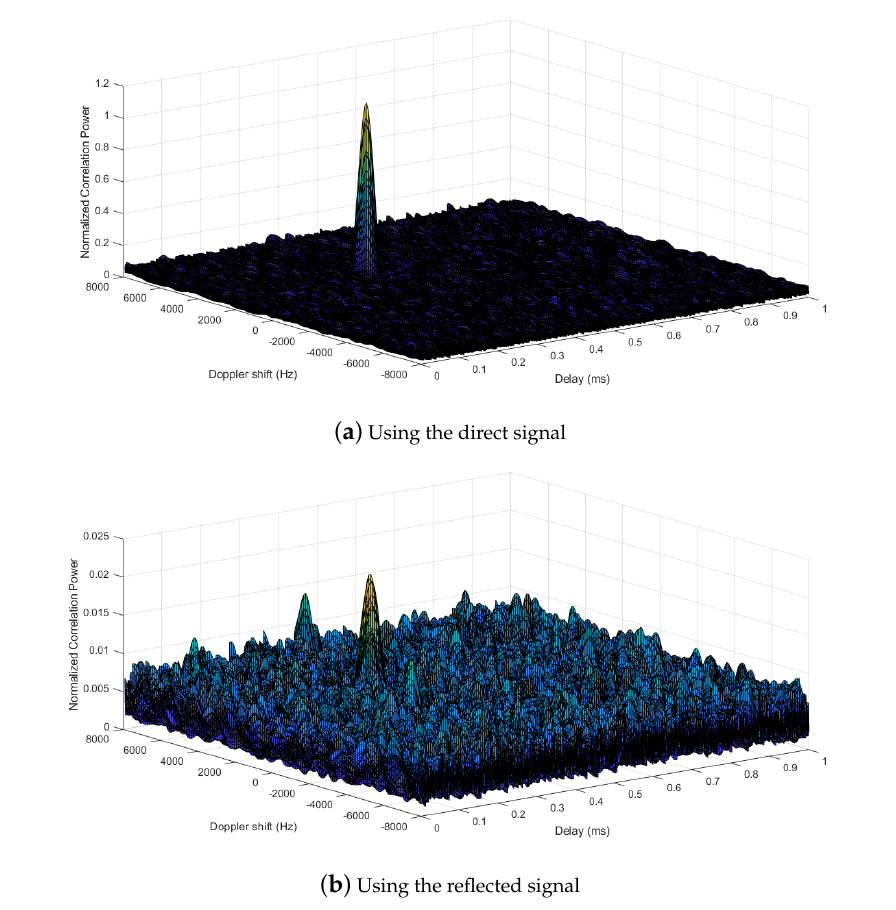
Figure 3. Examples of the search space for a visible satellite when ( a ) evaluated from the direct signal, and ( b ) evaluated from the reflected